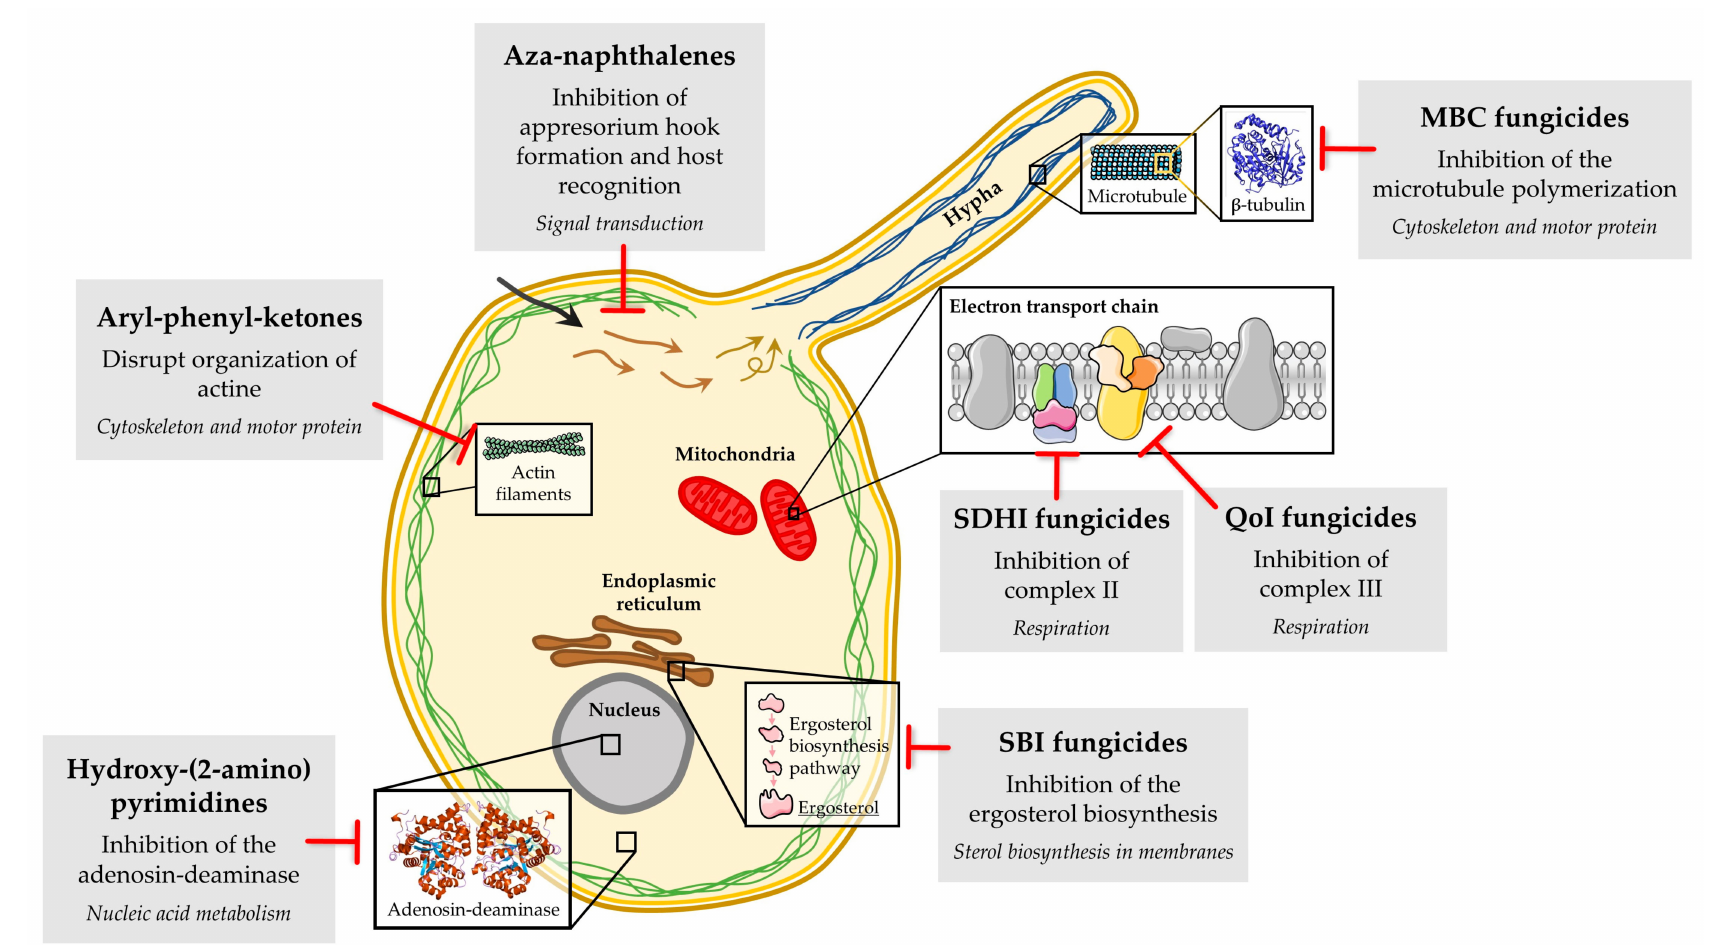
Figure 3. Biochemical mode of action of the main classes of fungicides with resistance described in powdery mildew